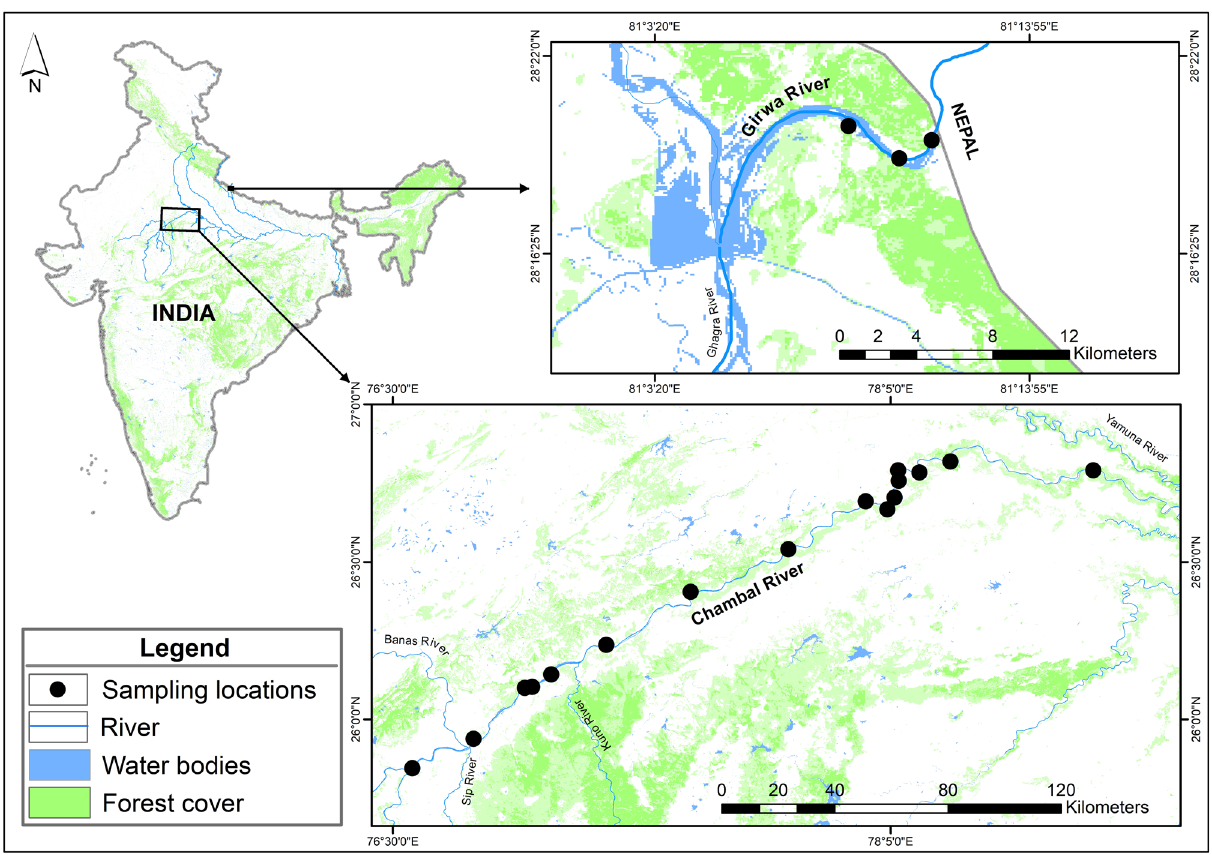
Figure 1. Map showing detailed representation of the study area and sampling locations along the Chambal and Girwa Rivers. The map was prepared using ArcGIS v.10.3.1 software developed by ESRI (https ://www.esri. com).